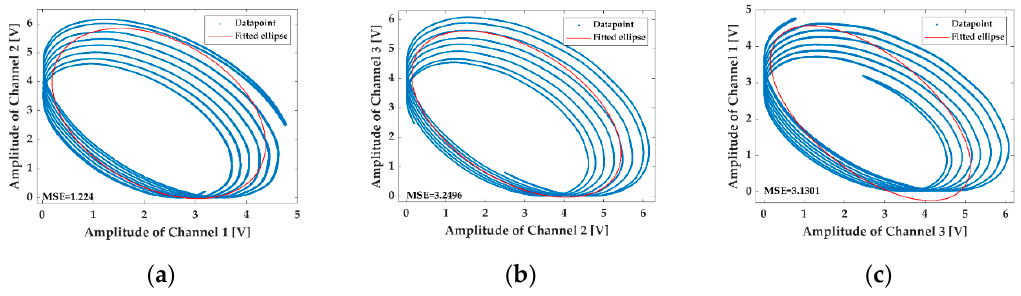
Figure 5. The LFs drawn by the experimentally acquired interferometric signals of the 3 × 3 coupler. ( a ) The LF drawn with Channel 1 and Channel 2; ( b ) the LF drawn with Channel 2 and Channel 3; ( c ) the LF drawn with Channel 3 and Channel 1.